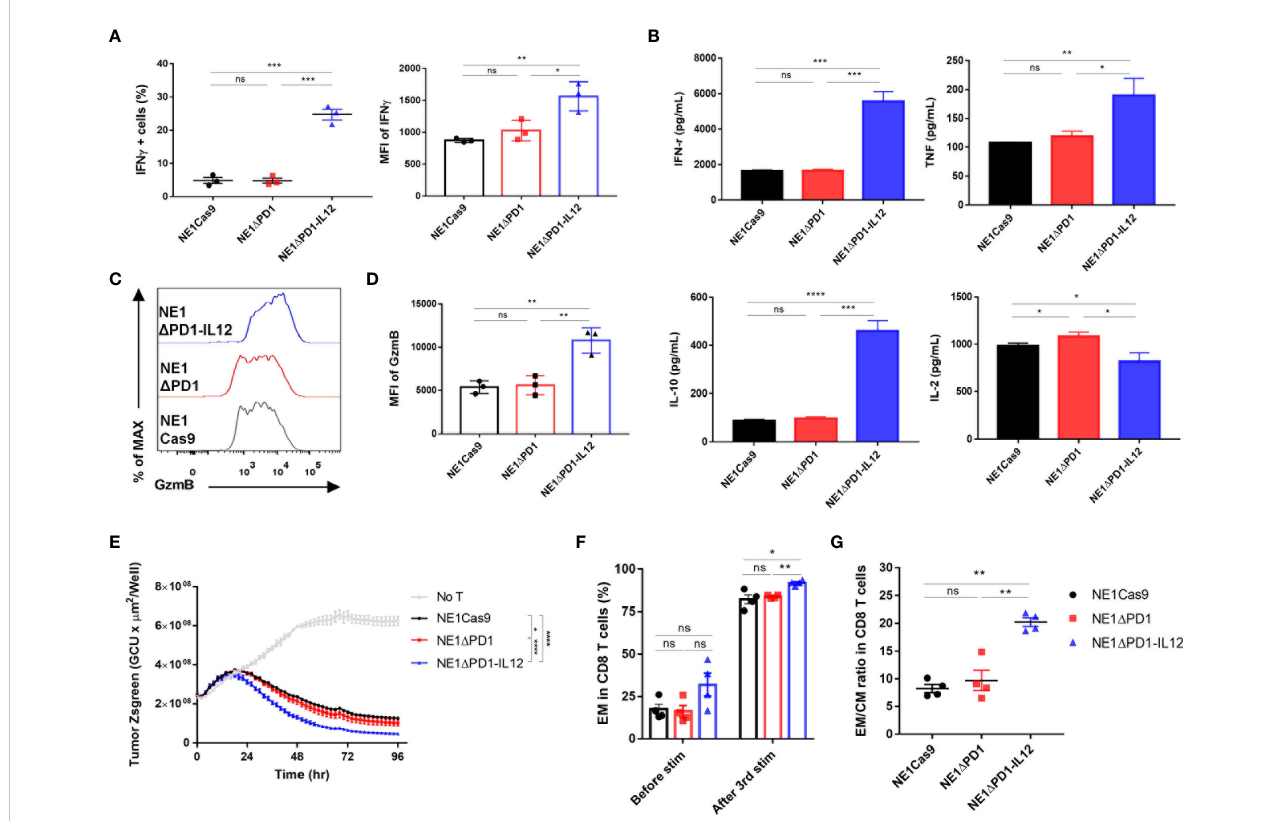
FIGURE 3 Enhanced effector function of D PD-1-IL-12-edited NY-ESO-1 TCR-T cells in vitro (A) Engineered T cells were co-cultured with A375 cells for 24 h. IFN- g secretion was determined using fl ow cytometry. The percentage of IFN- g positive cells and the MFI of IFN- g were quanti fi ed. Data are presented as the mean ± SEM (n = 3; three independent experiments with three donors). (B) Engineered T cells were co-cultured with A375 cells for 48 h and the cytokines (IFN- g , TNF, L-10, and IL-2) released into the culture supernatants were measured by CBA assay; results shown are representative of three experiments with three different donors. Data are presented as the mean ± SD of triplicates. (C) Engineered T cells were co-cultured with A375 cells for 48 h. The GzmB expression was determined by intracellular fl ow cytometric analysis. (D) The MFI of GzmB in the engineered T cells shown in (C,